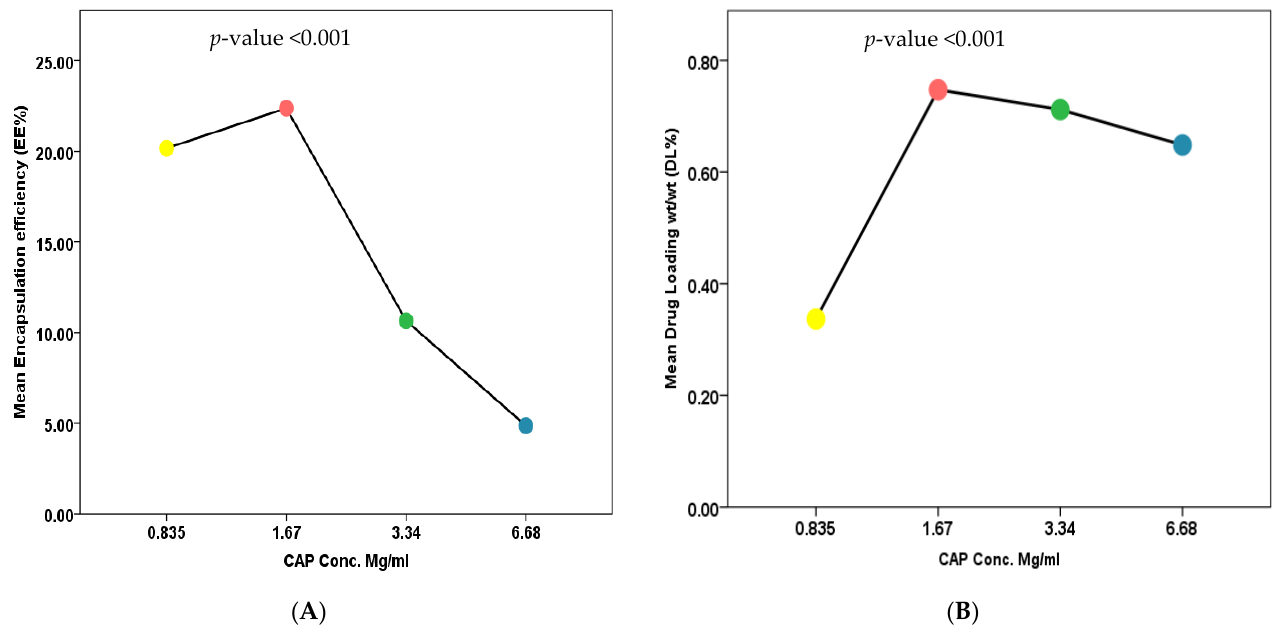
Figure 3. Effect of CAP amount on CAP-loaded nanoliposomes ( A ) %EE and ( B ) %DL. The results showed that we had a strong negative correlation as CAP amount in- creases in value, the %EE decreases in value with p value (2-tailed) at <0.001 and Pearson correlation of − 0.828, which means that we have a reverse relationship between CAP amount and %EE. Furthermore, when the impact of CAP amount on %DL was studied, data showed a significant difference across different formulas (F2, F4, F5, and F6) with p - value < 0.001. A multiple comparison was performed using LSD procedure at α = 0.05, where %DL data represented that F2 (mean = 0.75 ± 0.20), F5 (mean = 0.71 ± 0.06) and F6 (mean = 0.65 ± 0.15) were significantly higher %DL than F4 (mean = 0.34 ± 0.20) with p value < 0.001, < 0.001, and < 0.001, respectively. Whereas, F2 showed no significant differ- ence in comparison with F5 and F6 with p value = 0.637 and 0.197, respectively. Besides, F5 and F6 showed no significant difference with p = 0.470. From the data above, we found that F2 showed the highest mean of %DL, and as we increase CAP amount, there was a slight decrease in %DL, as shown in Figure 3. Maximum encapsulation of CAP inside liposomes in F2 was reached, with highest %DL and any increase in CAP amount could cause a reduction in %EE and %DL.